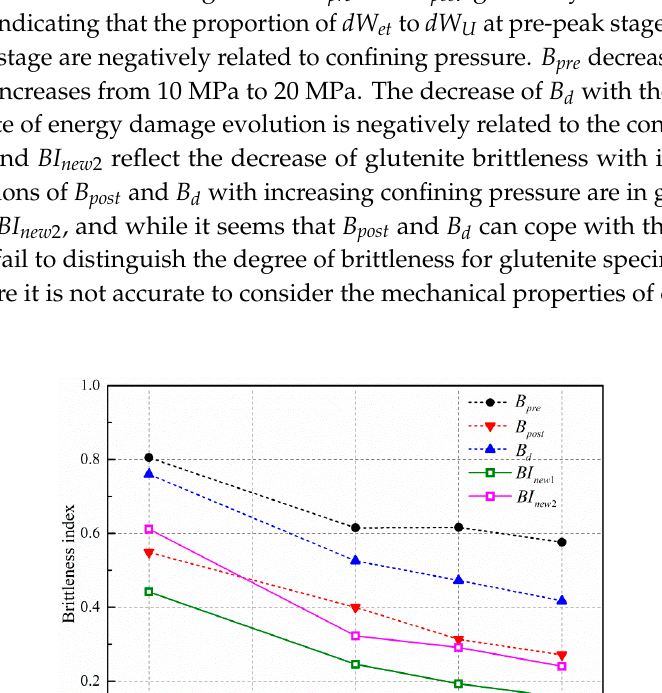
BI and B of glutenite under uniaxial and triaxial stress. 1 new d